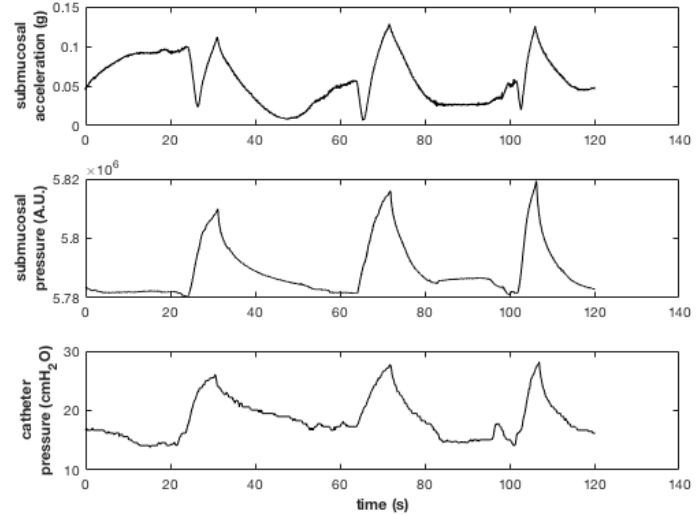
Figure 3. Signals recorded during three consecutive manual infusions of saline